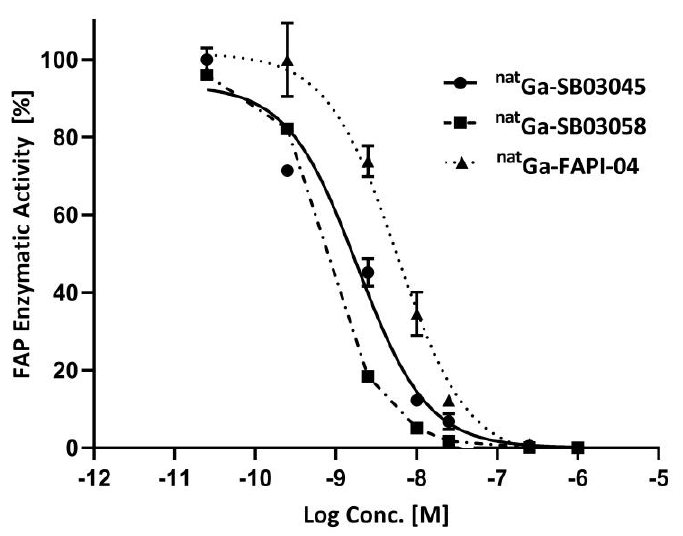
Figure 2. Inhibition of FAP-mediated cleavage of Suc-Gly-Pro-AMC substrate by various concentra- tions of nat Ga-SB03045, nat Ga-SB03058, and nat